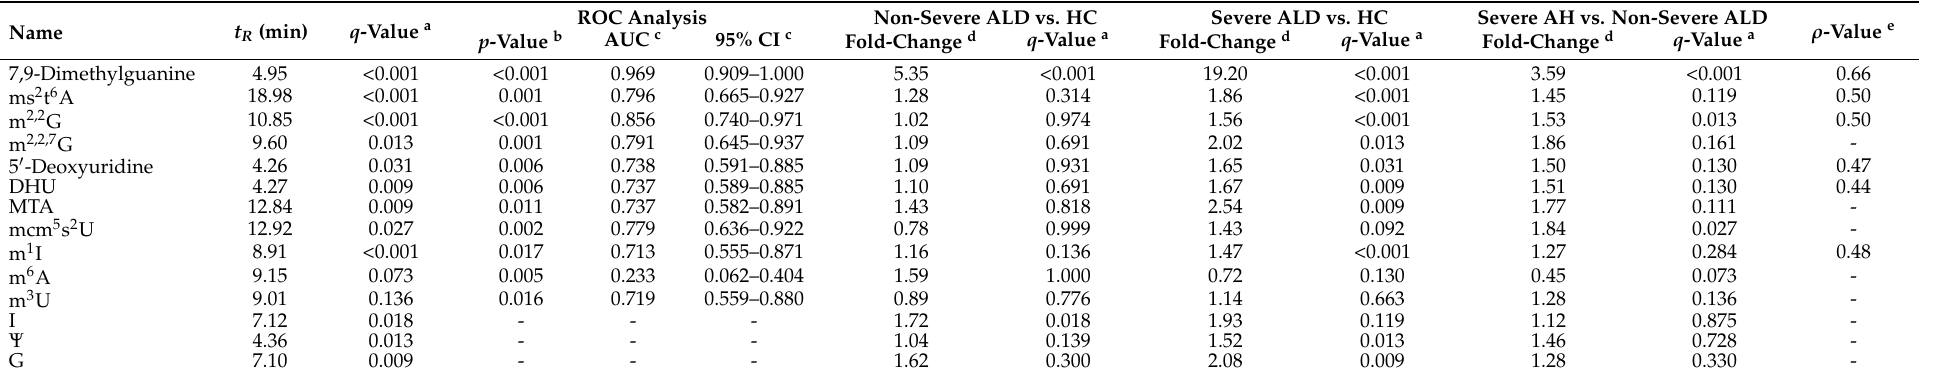
Table 3. Significantly changed nucleosides in human urine